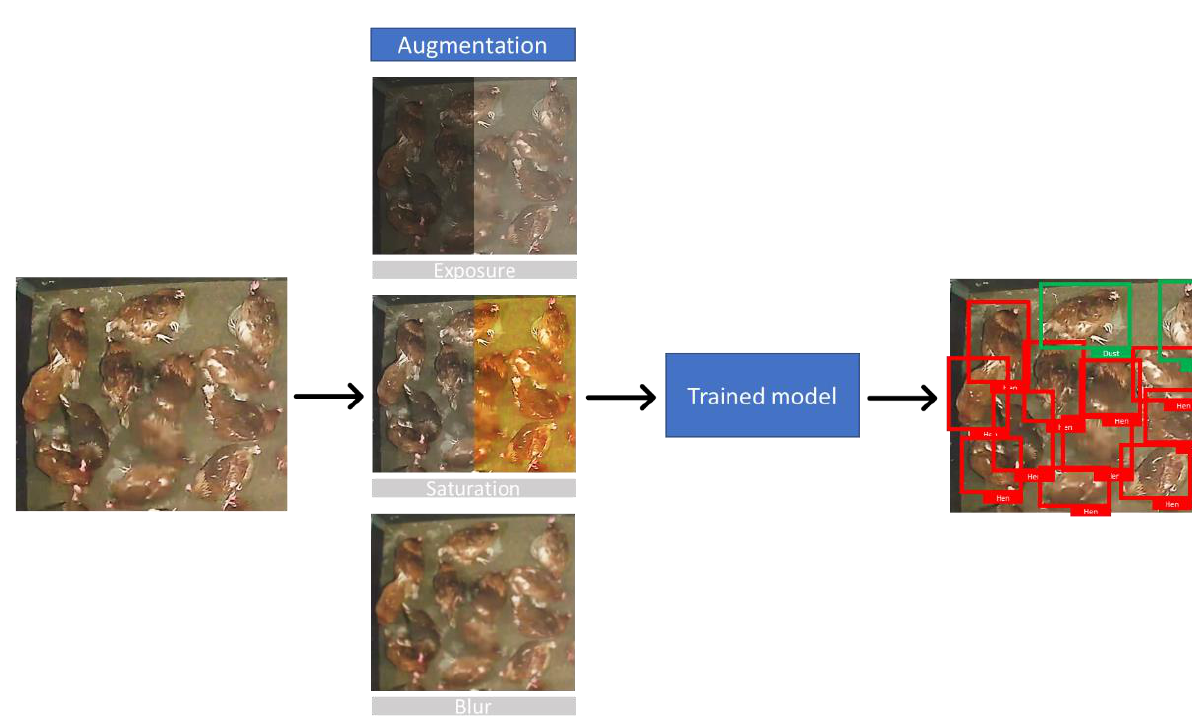
Figure 2. Augmentation and classification scheme for laying hens on the floor (red boxes) and dust-bathing hens (green boxes).